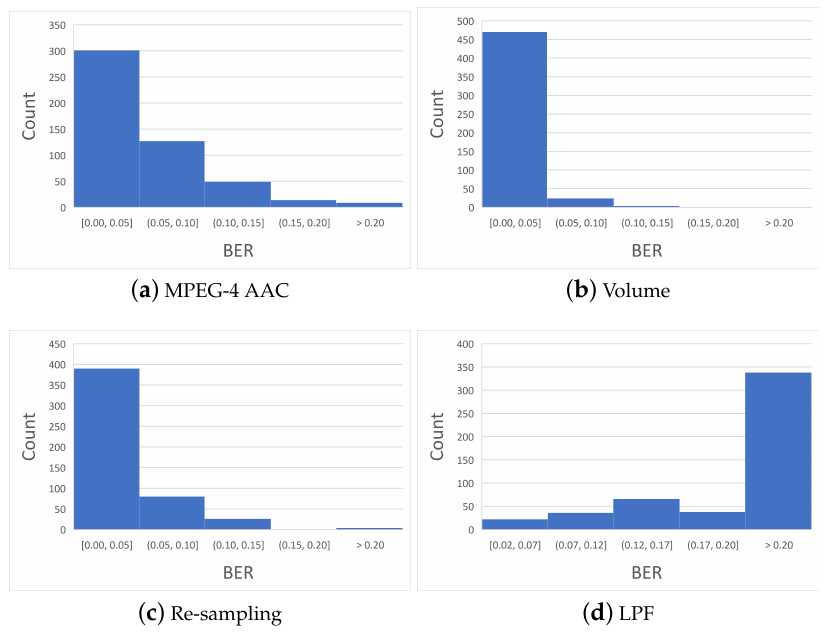
Figure 5. Perceptual tests